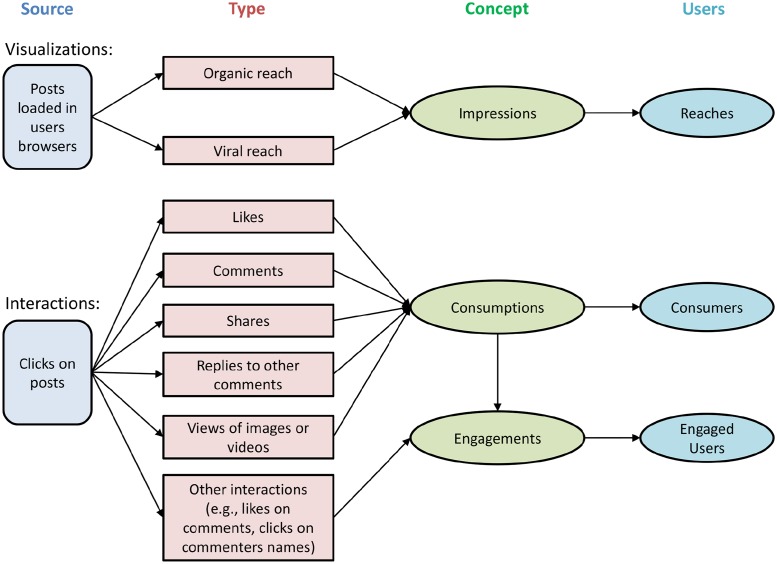
Facebook post performance conceptual map [27].